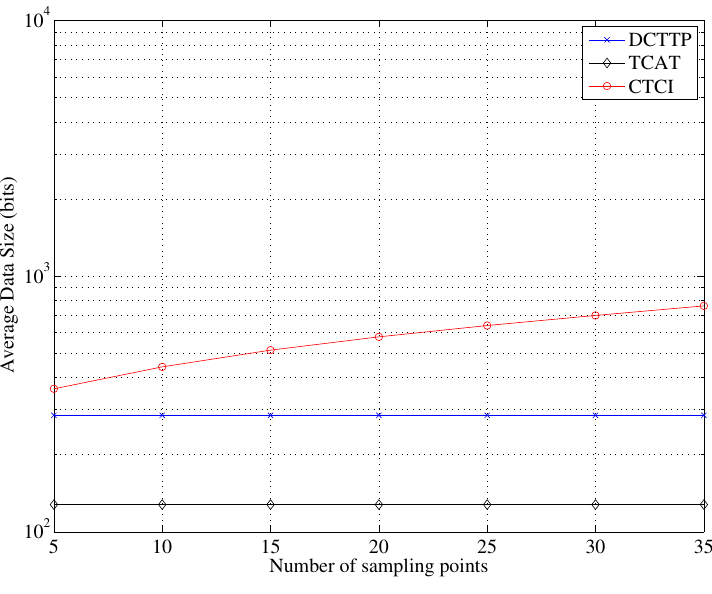
Figure 21. Impact of the sampling points on the average data size.